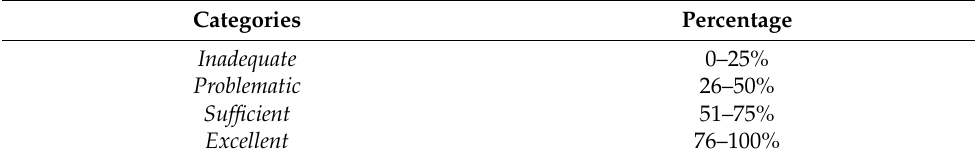
Table 2. Qualitative categories of the scientific knowledge in health with Zika